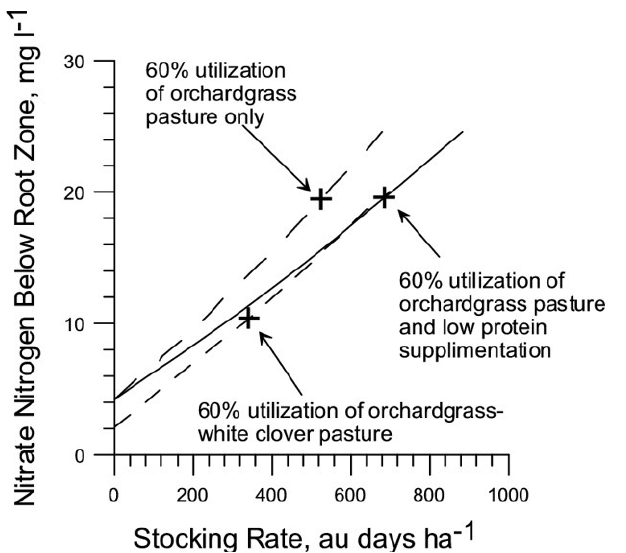
-N in leachate beneath pasture and stocking 3